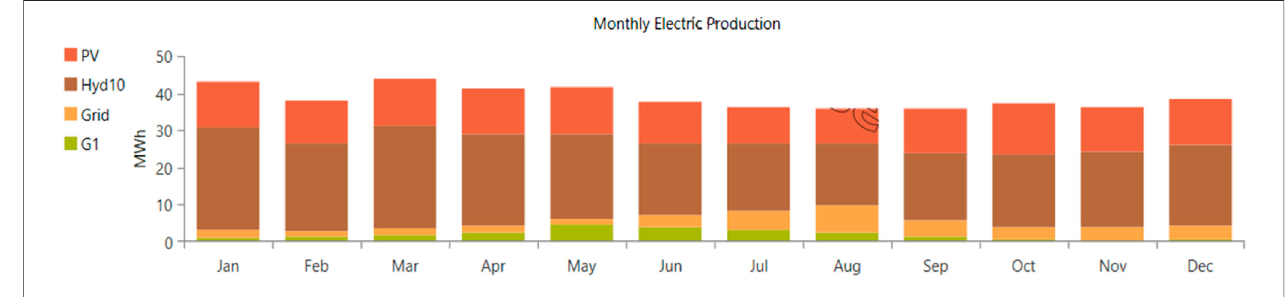
FIGURE 4 | Monthly average electric production.